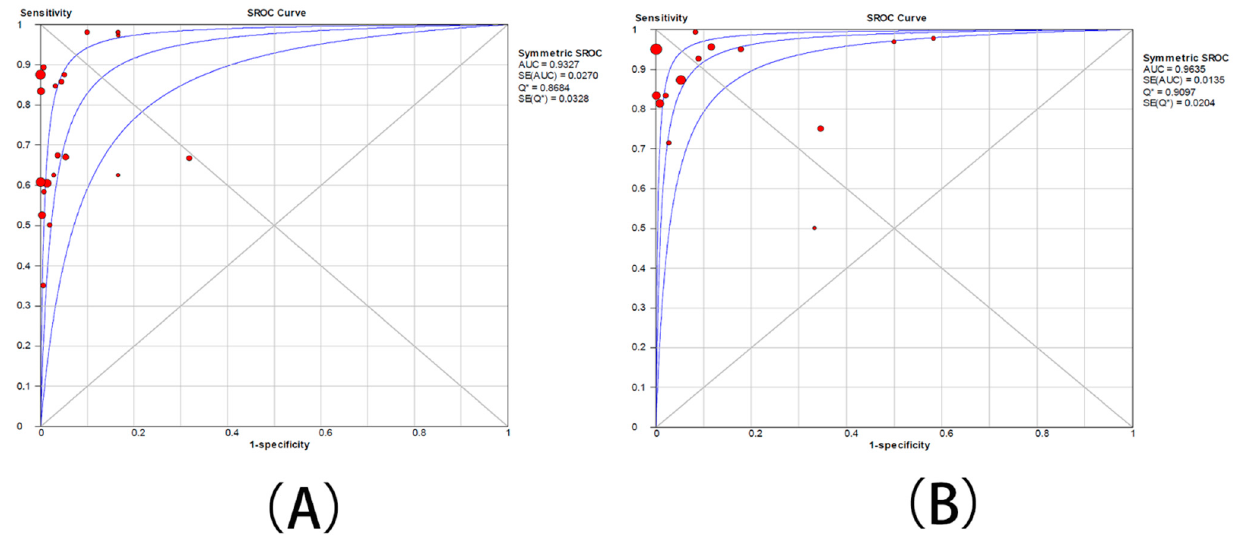
Figure 6. sROC curve of fourteen studies with both sensitivity and specificity rates. ( A ) The group with moderate resistance limited to 2–128 mg/L. ( B ) The group with moderate resistance limited to 4–128 mg/L. Q* defined by the point where sensitivity and specificity are equal.